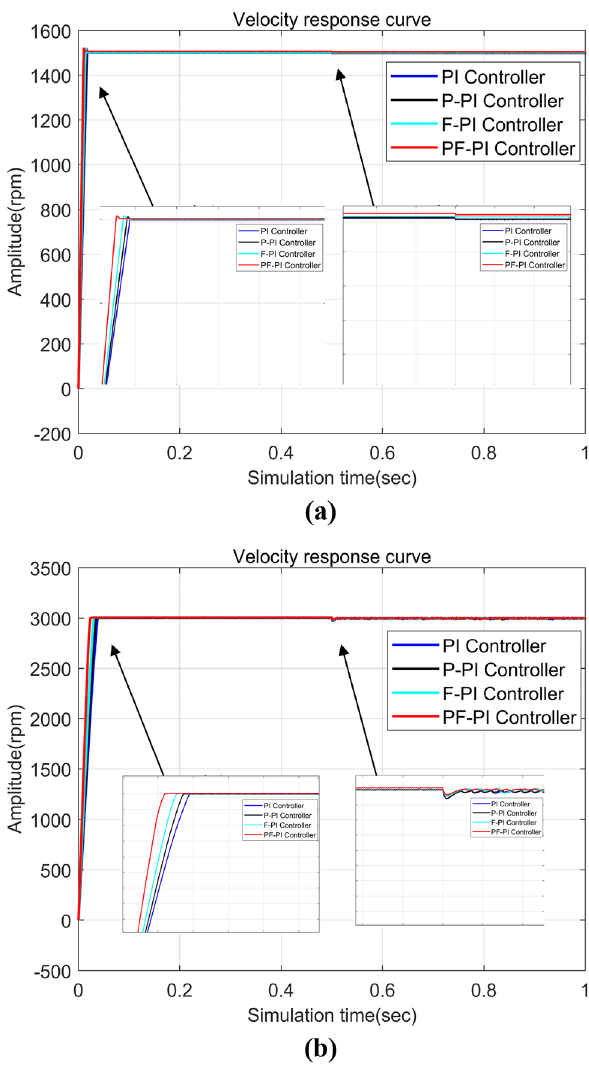
Fig. 16 Speed response curves of sudden addition distur- bance load start under different conditions a 0–1500 rpm and